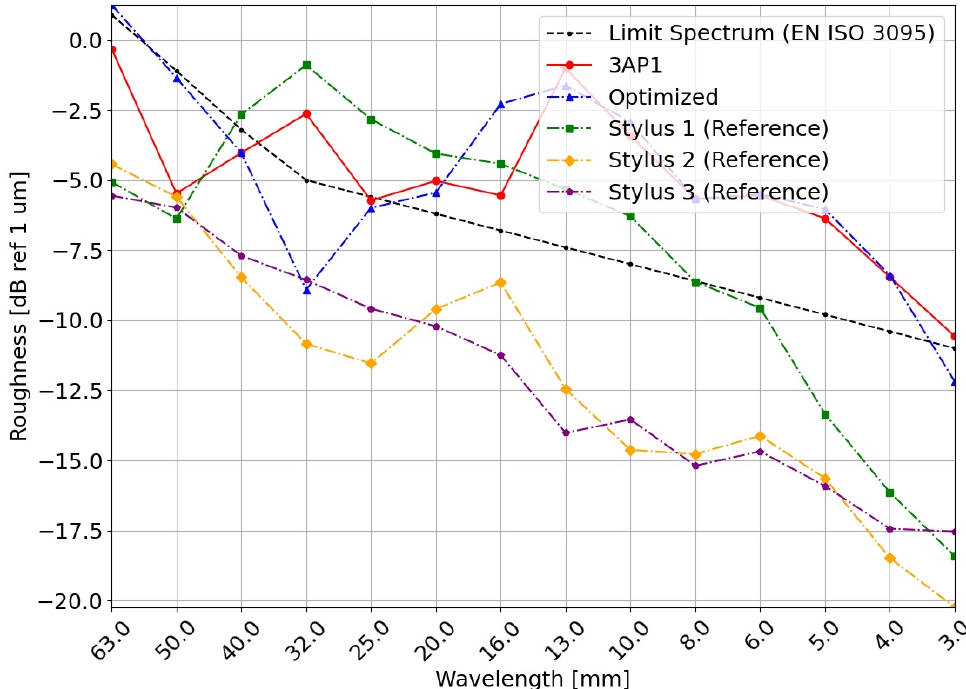
Figure A4. Spectrum of acoustic roughness for measurement of the optical system near reference section A, compared with reference section A and the limit spectrum from EN ISO 3095 [22].